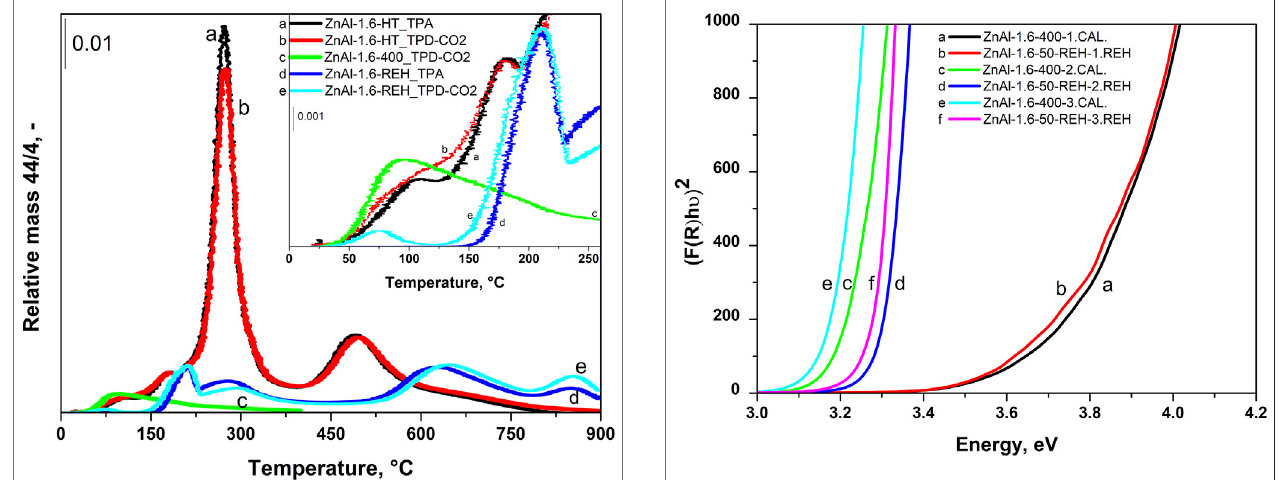
FIGURE 8 | In-situ DRS during repeating transformation of mixed oxide intoreconstructed materiel,i.e.thespectraofZnAl-1.6-400 mixedoxide(after thermal treatment of ZnAl-1.6-HT at 400 ° C for 4 h), ZnAl-1.6-50-REH (after gas phase treatmentofZnAl-1.6-400 mixed oxide at 50 ° C for4 h),ZnAl-